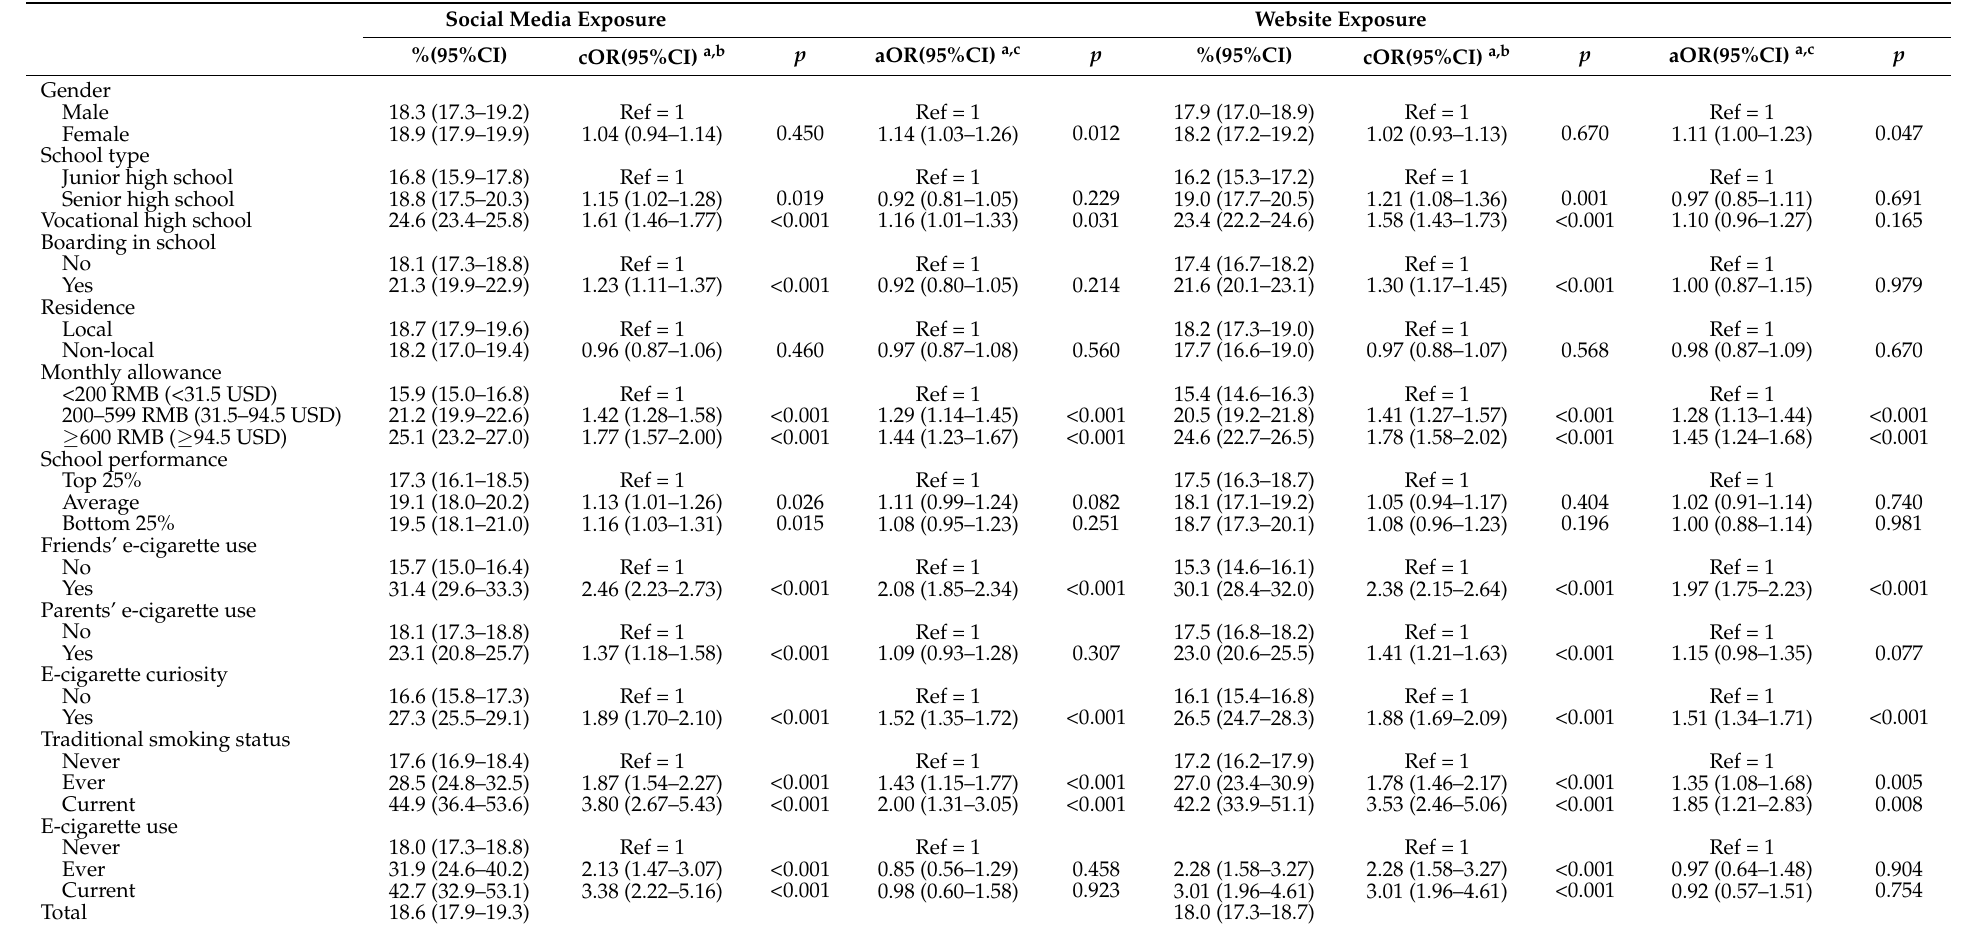
Table 2. Online e-cigarette information exposure and its influencing factors (N =